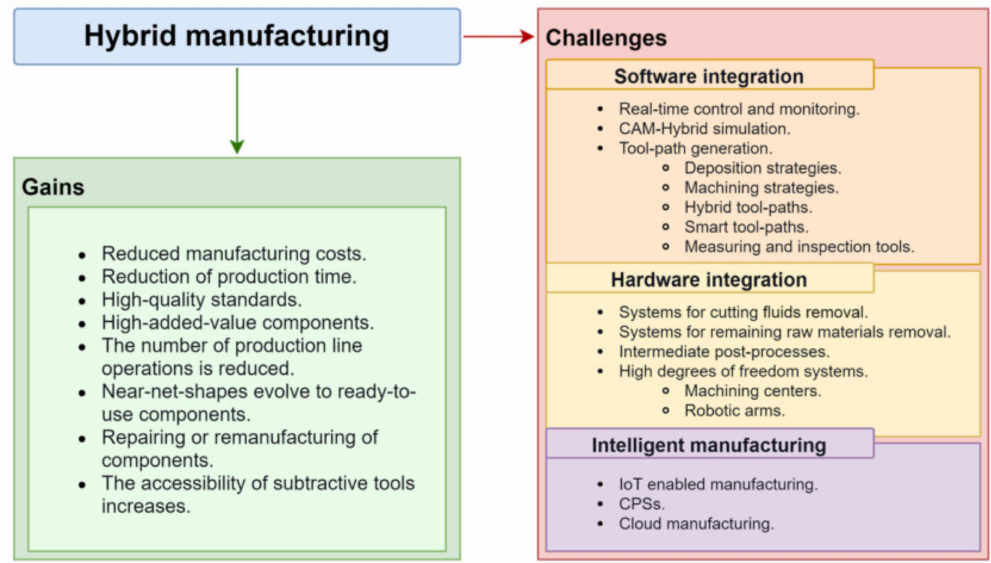
Figure 12. Hybrid manufacturing gains and challenges. IoT = Internet of things; CPSs = cyber-physical systems